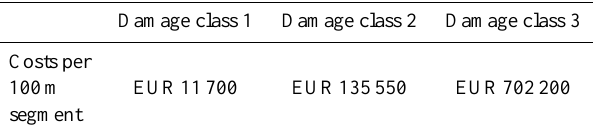
Table 1. Standard repair costs per 100m segment of a double- tracked railway standard cross-section. The costs of damage class 1 are attributable to damage documentation and cleaning of the track segment. The standard repair costs for damage class 2 were already calibrated by adding a coefficient of 0.25 (see Sect. 2.4). The cost value for damage class 3 complies with the overall damage potential of a 100m track segment, including costs for damage documenta- tion and